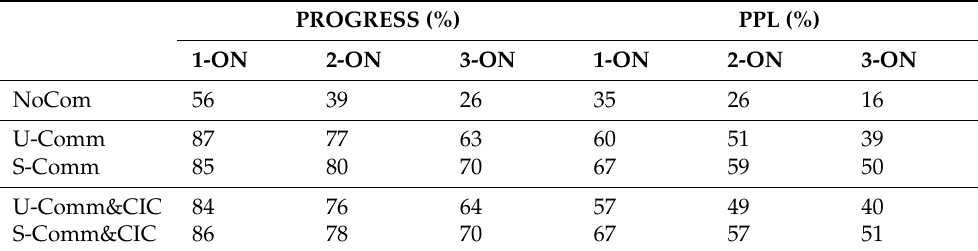
Table 4. Task performance metrics for different communication mechanisms evaluated in Habitat. The communication penalty is set to r comm-penalty = −